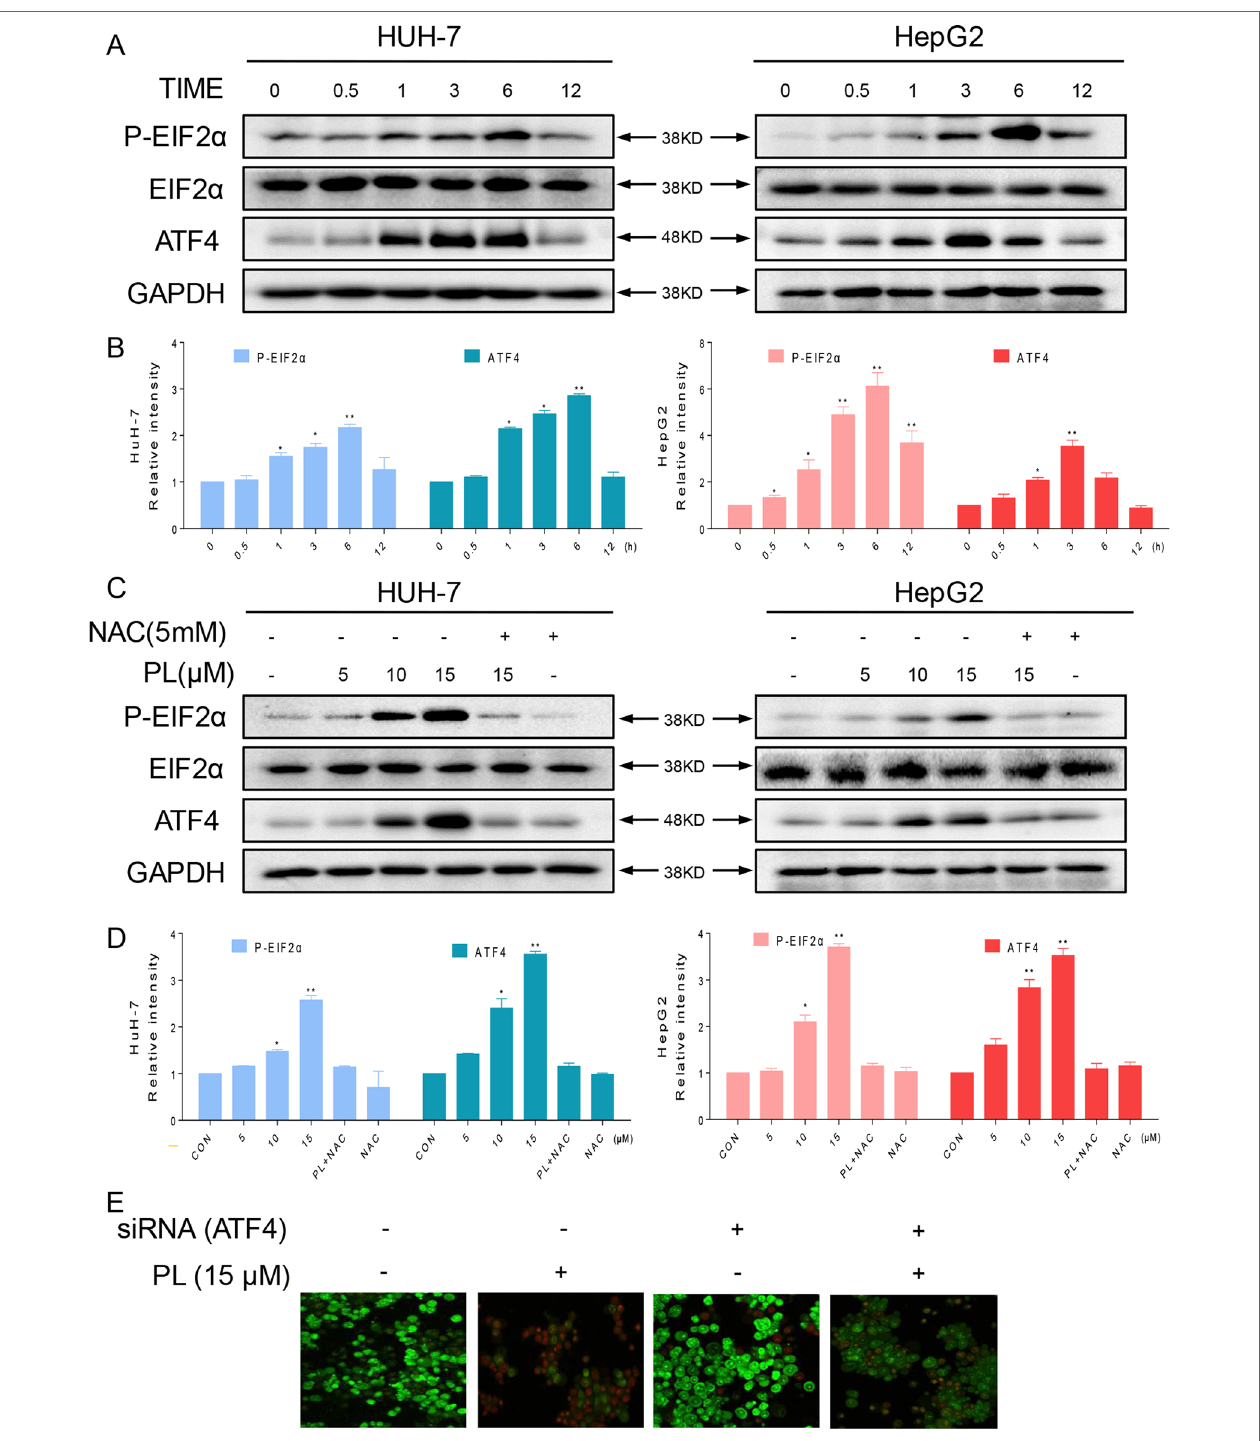
FIGURE 4 | The ER stress pathway is involved in PL-induced apoptosis by promoting the accumulation of ROS. (A) HUH-7 and HepG2 cells were treated with PL (15 μM) for the indicated times, and the protein levels of p-eIF2 α and ATF4 were determined by western blotting. GAPDH and eIF2 α were used as internal controls. (B) Western blot results from (A) were calculated and compared with the control. (C) HUH-7 and HepG2 cells were pretreated with or without 5 mM NAC for 2 h before exposure to PL at the indicated concentrations. Six hours later, ATF4 and p-EIF2 α expression was detected by western blot. GAPDH and eIF2 α were used as internal controls. (D) Western blot results from (C) were calculated and compared with the control. (E) HUH-7 cells were transfected with siRNA against ATF4. Cells were then exposed to 15 μM PL and apoptotic cells were determined by acridine orange and ethidium bromide dual staining. Data represent similar results from three independent experiments. Western blot results were calculated and represent the percentage of the control (*p < 0.05, **p <